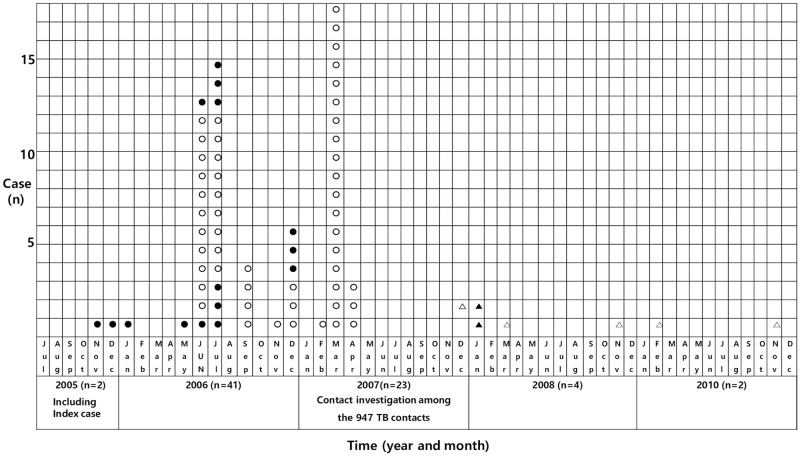
Scheme of TB outbreak in a single high school in Korea.Each symbol in column represents one student and placed at the point at which the student was diagnosed as active TB.● = Active TB cases with positive AFB culture; ○ = Clinical TB cases with negative AFB culture; ▲ = Active TB cases with positive AFB culture and smear developed during follow-up among contacts who were TST+/QFT-; Δ = Clinical TB cases with negative AFB culture developed during follow-up among contacts who were TST+/QFT-; TB = tuberculosis; AFB = acid fast bacilli; TST = tuberculin skin test; QFT = QuantiFERON-TB Gold In-Tube test.